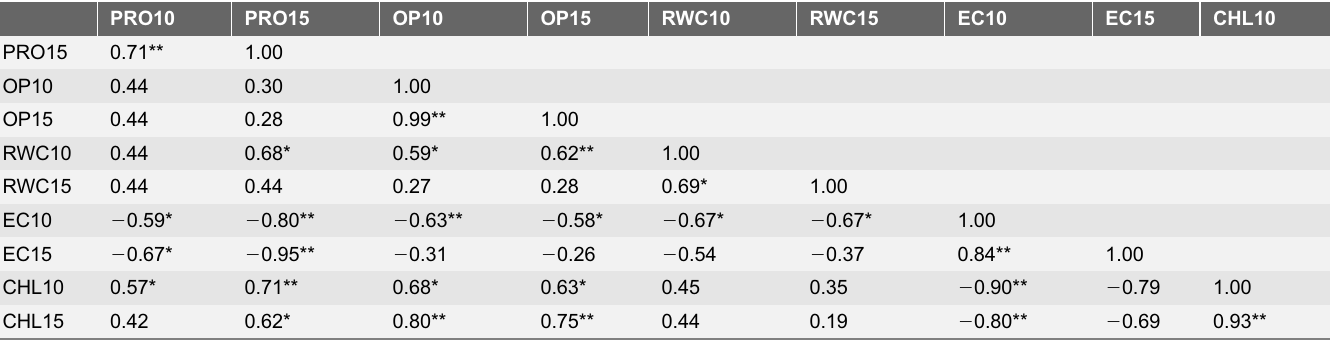
Table 3. Correlation coefficient (r) between the different physio-biochemical parameters under various concentration of PEG after 7 days of